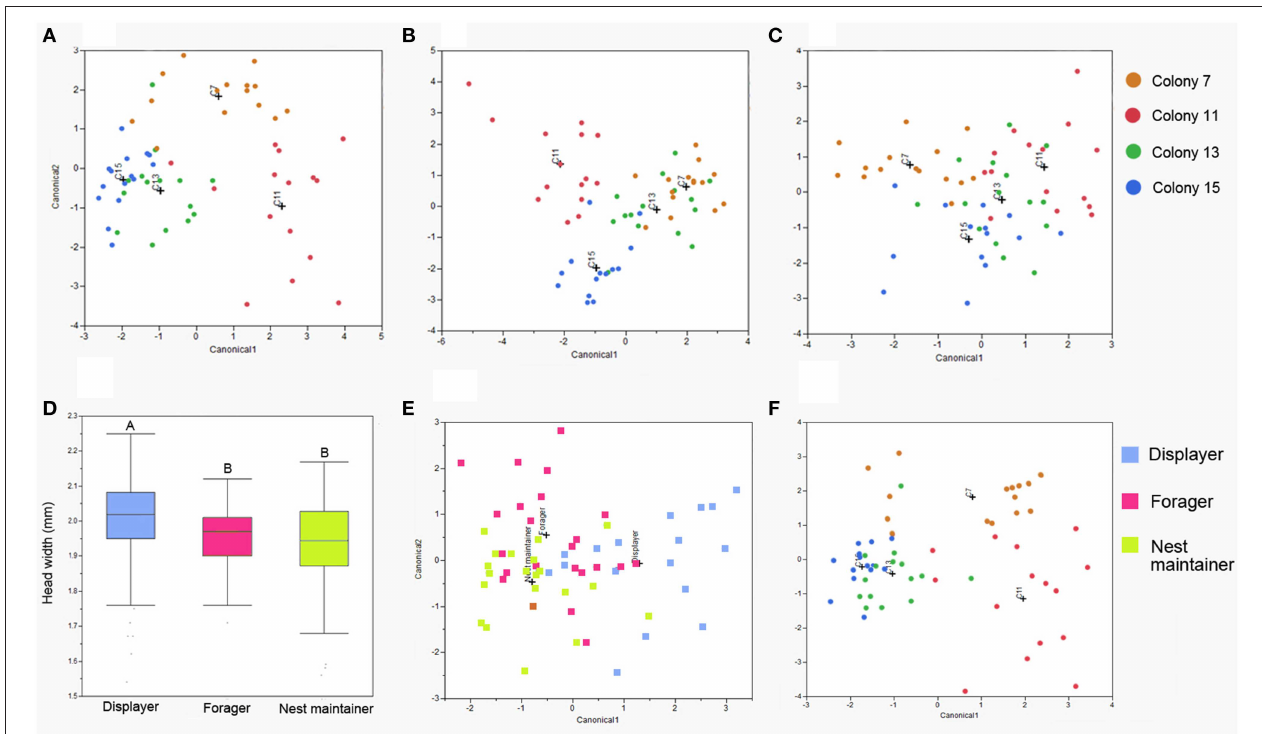
FIGURE 1 | Discriminant analysis of the CHCs on different body parts and body size variation between tasks. Task discriminant analysis plots of (A) antennae, correctly classifies 71.7% individuals, (B) legs, correctly classifies 81.4% individuals, and (C) abdomens, correctly classifies 69.5% individuals. (D) Displaying workers are slightly larger than workers engaged in other tasks: box covers 25–75% quartiles and whiskers complete the range of values; different letters indicate significantly ( p < 0.05) different levels. (E) Task and (F) colony discriminant analysis plots using the components selected by GLMNET from legs (correctly classifies 78.0% individuals) and antennae (correctly classifies 86.4% individuals). + marks the centroid of each